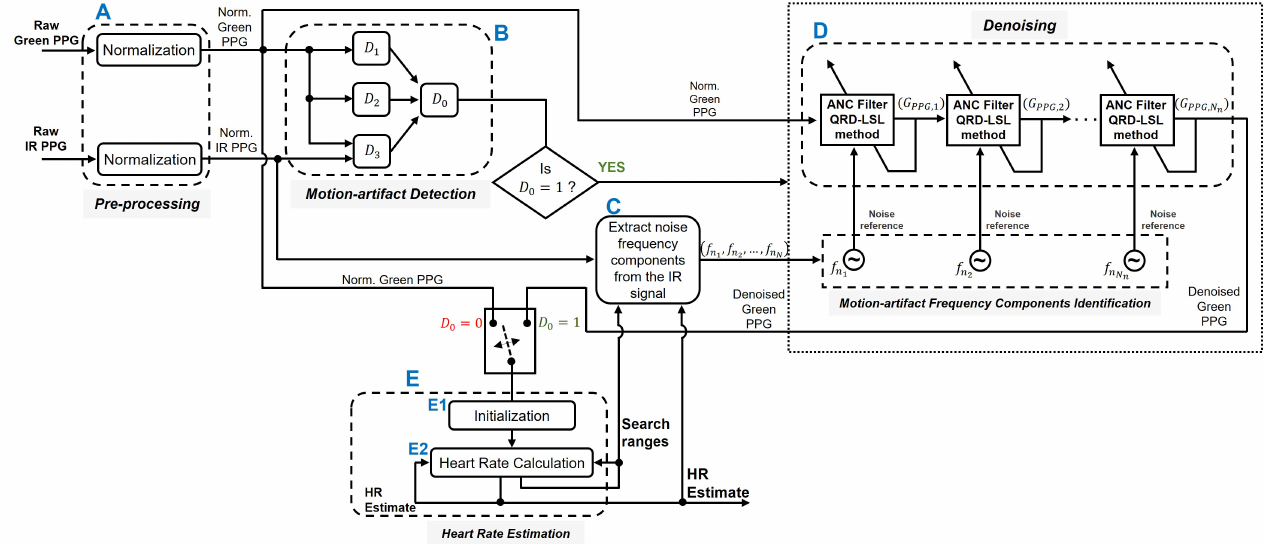
Figure 3. Block diagram of the DWL method. The inputs for calculating HR are raw green and IR PPG signals. The output is an estimate of the participant’s HR. Block A corresponds to the pre-processing stage of Section 2.3.1. Block B represents the motion-artifact detection stage of Section 2.3.2, which we employed to determine whether the PPG signals are contaminated with appreciable level of noise. Block C identifies the motion-artifact frequency components as described in Section 2.3.3. During this stage, noise frequency components are extracted from the IR PPG signal. Block D is the denoising stage of Section 2.3.4, during which noise components are removed from the green PPG signal. Block E corresponds to the heart rate estimation stage of Section 2.3.5, which we used to extract an HR estimate from the green PPG signal. Block E1 is the HR “Initialization” stage, during which the initial HR value is computed. Block E2 illustrates the motion-resistant HR calculation